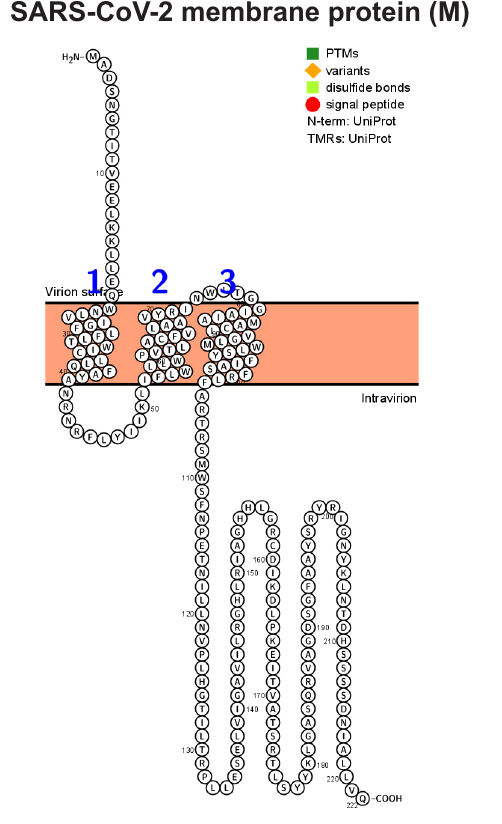
Figure 3. Membrane topology of proteins (snake diagrams) determined using Protter. (A) The membrane (M) glycoprotein of SARS-CoV-2 has a triple helix bundle and formed a single 3-transmembrane domain. (B) Snake diagram of envelope (E) protein, (C) nucleocapsid (N) protein, and (D) spike protein